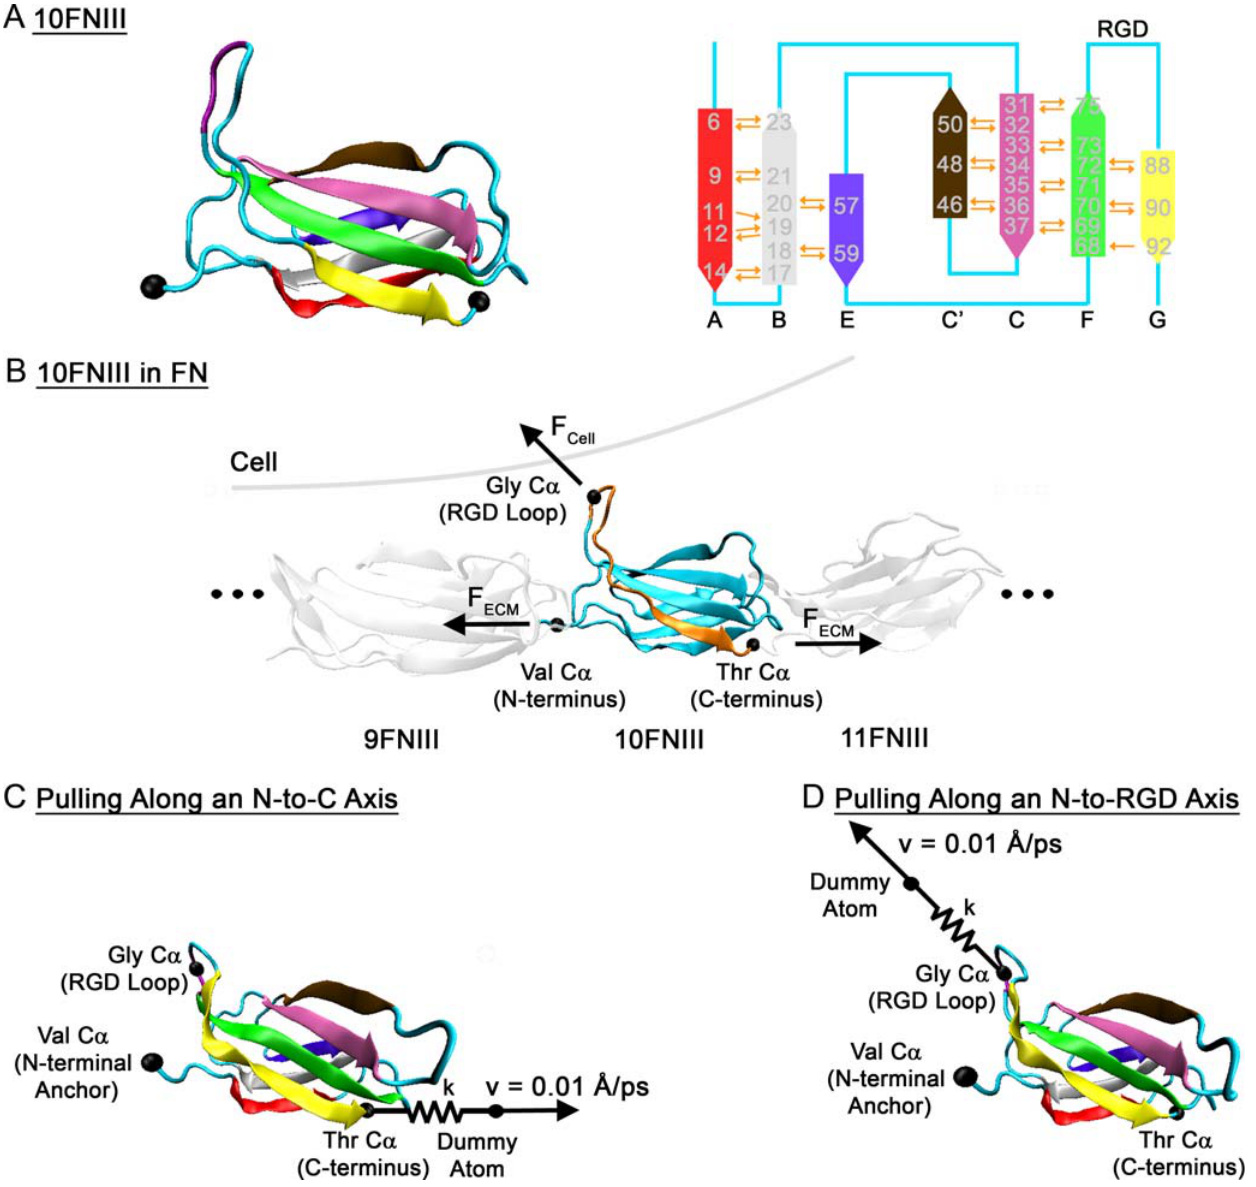
Figure 1. Local Environment of 10FNIII. (A) Crystal structure of 10FNIII. On the left is the cell-binding module of FN (type III), whose globular folded form is composed of seven b -strands split between two b -sandwich sheets. The RGD loop is highlighted as purple in the loop connecting b - strands F and G . N- and C- termini are labeled as black spheres. On the right is a schematic topology map of the secondary structure of 10FNIII with each b -strand labeled and color-coded corresponding to the crystal structure on the left. b -strand boundaries are adapted from the crystal structure as previously shown [17]. Residues participating in hydrogen bonds (orange arrows pointing in the direction from hydrogen bond donor to acceptor) are labeled in gray. Hydrogen bonds shown are between backbone atoms of the b -strand residues and are calculated for distances within 3.5 A˚ and angles within 120 u –180 u using the software VMD. (B) 10FNIII as it sits in FN. 10FNIII, adjacent to the ninth (9FNIII) and eleventh (11FNIII) type III modules, experiences two types of forces. The cell can directly apply force (F CELL ) at the RGD loop by binding through a cell-surface integrin and applying cell traction. Force can also be applied to FN indirectly through the ECM (F ECM ). F ECM represents the forces generated by cells bound to remote sites in the ECM that are propagated to 10FNIII through neighboring domains bonded at the N- and C- termini. Residues C-terminal to the RGD loop (highlighted in gold) adopt a relatively extended conformation. (C) Pulling along an N-to-C axis. The protein is anchored at the C a atom of the N-terminal residue (Val1416), and force is applied through a spring (with spring constant k ) attached at the pulling point by translating the free end (attached to a dummy atom) at constant velocity (v=0.01 A˚/ps) in the defined direction. This process transmits force to the attached C a atom of the C-terminal residue (Thr1509). Each b –strand is color-coded and labeled as in (A). (D) Pulling along an N-to-RGD axis. The C a atom of the N- terminus is anchored, and the pulling force is exerted through a spring attached to the C a atom of the Gly residue in the RGD tripeptide. Each b – strand is color-coded and labeled as in (A). unfolding. Of particular interest are specific residues near the position R1445, which sits approximately 11 A ˚ from the RGD RGD loop that have been shown to be important for high affinity loop (Figure 6A), can significantly hinder the ability of cells to bind binding to integrins. For example, non-conservative mutations at FN fragments in vitro [25,26]. R1445 therefore appears to play a